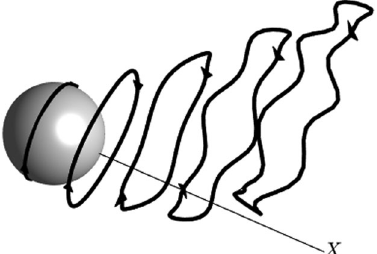
FIG. 6. Rough illustration of the drag mechanism by generation and outward flux of vortex loops with negative azimuthal vorticity. The rings are generated by pressure drop along the surface. As the rings expand outward, they enclose greater mass flux J and subtract proportionate energy from the potential flow. Although the rings initially loop around the streamwise axis X , they drift across in time. This implies a flux of azimuthal vorticity across X and allows the pressure to recover far downstream from its drop around the